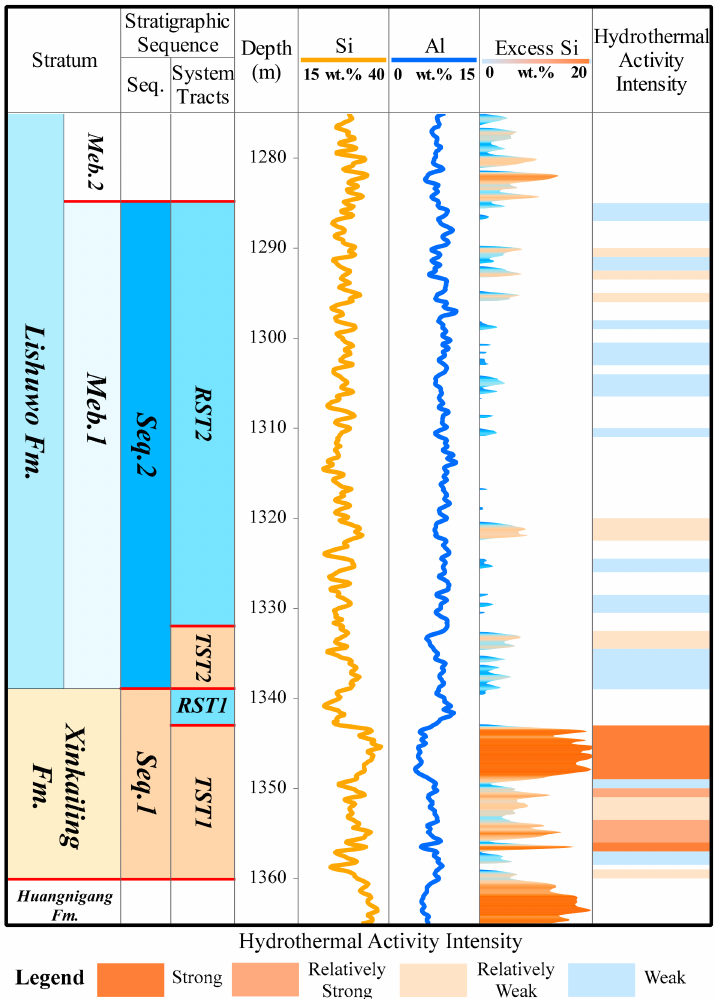
Figure 4. The analysis of hydrothermal activity intensity of Xinkailing Fm. and the first member of the Lishuwo Fm. in Well X, the Lower Yangtze. See Figure 1 for the well location. Al = aluminum, Si =